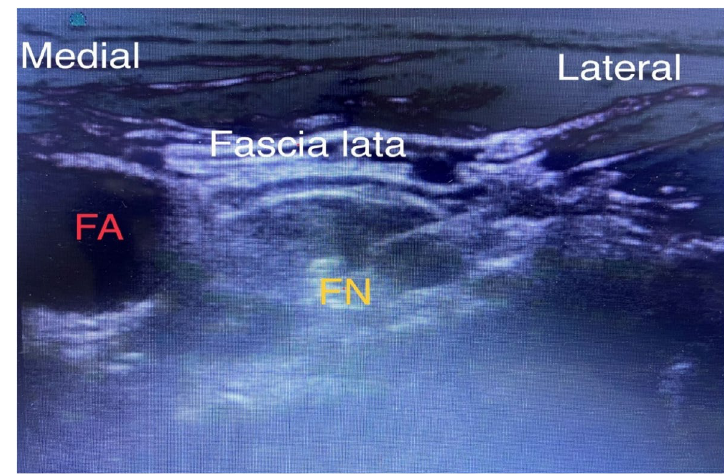
Fig. 1 Spread of local anaesthetic before femoral catheter advancement. Femoral artery (FA), Femoral Nerve (FN)